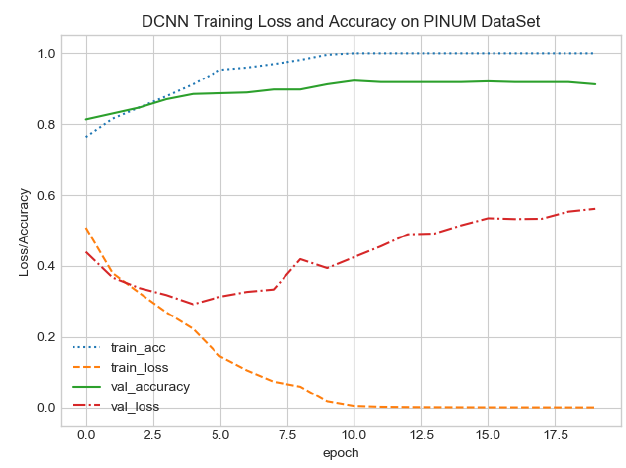
Figure 9. DCNN training loss and accuracy on the PINUM